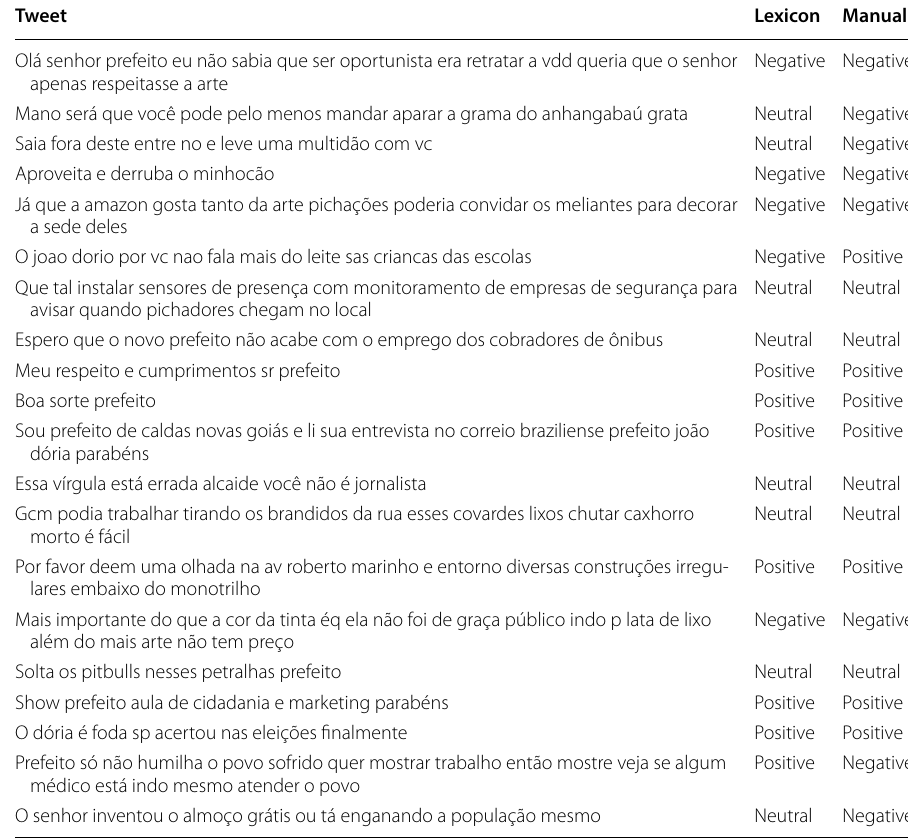
Table 2 Comparison of sentiment classified by Lexicon and manually Tweet Lexicon